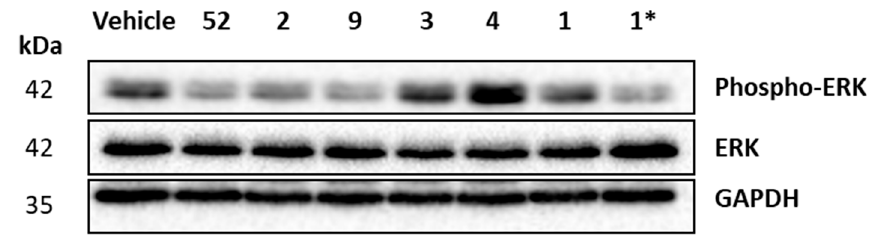
Figure 6. Western immunoblot of HL-60 cell extracts following incubation with compounds 2 , 3 , 4 , 9 , 52 and 1 (as a control). HL60 cells were seeded at 2 × 10 5 cells / mL and were treated with either vehicle [0.5% EtOH ( v / v )], compounds 52 , 2 , 9 , 3 and 4 (5 µ M) or compound 1 (5 and (*) 10 µ M, as in reference [9]) for 16 h. Cells were lysed and equal amounts of protein were loaded and separated on 15% SDS-PAGE gels, transferred to PVDF membrane and probed with antibodies against total and phosphorylated ERK. Anti-GAPDH was used as a loading control. Results are representative of 2 independent experiments.